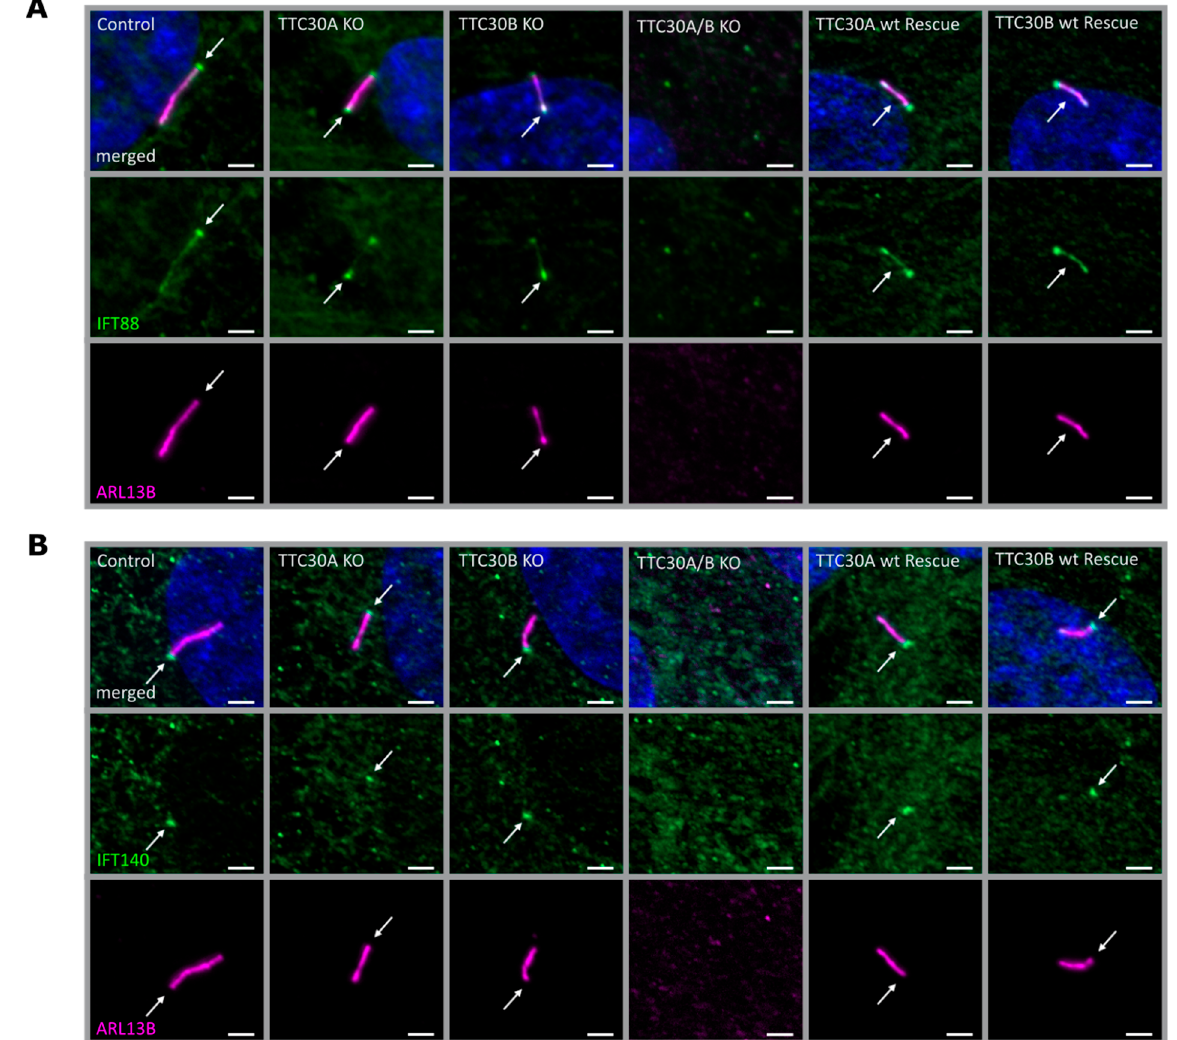
Figure 4. Fluorescent light microscopy images of hTERT-RPE1 control, TTC30A, TTC30B, TTC30A/B double-KO cells, TTC30A and TTC30B rescue (from left to right) are shown. The cells were stained for ARL13B (magenta), DNA is marked in dark blue and co-localization shown in white. The green channel depicts IFT88 ( A ) or IFT140 ( B ). The scale bar measures 2 µm. To investigate the localization of IFT88 and IFT140 at the basal body, co-staining with γ -tubulin in hTERT-RPE1 control, TTC30A KO, TTC30B KO and TTC30A/B